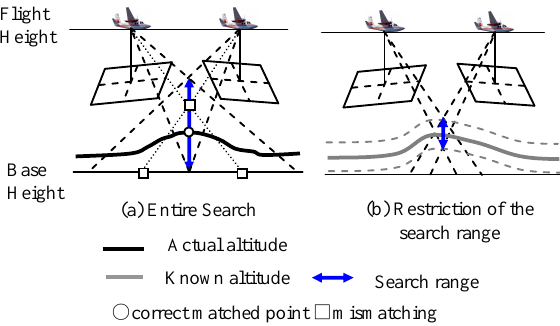
Figure 3. Matching process on the lowest resolution stage in the coarse-to-fine